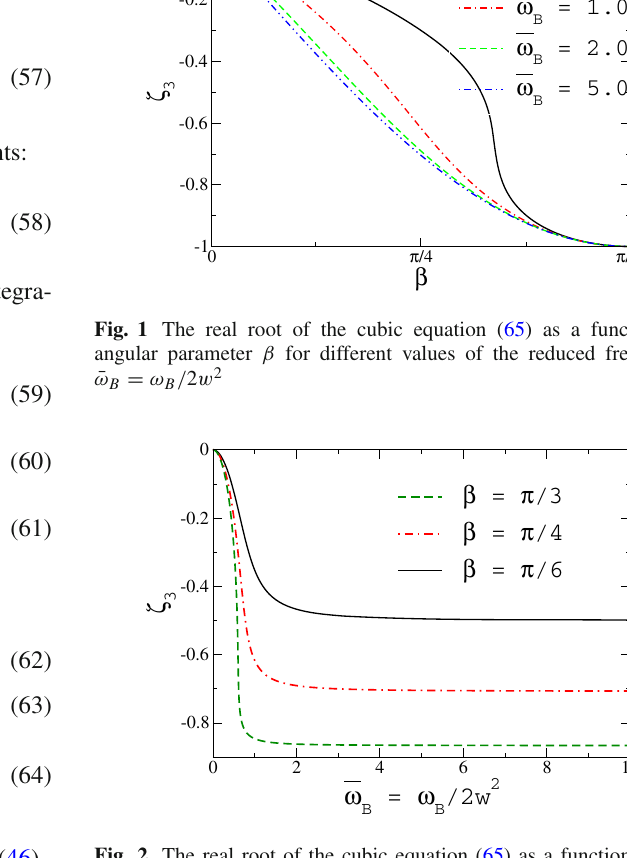
β . One can see that ζ − 1 3 monotonically decreases from 0 to with increasing β from 0 to π/ 2, and the indicated decrease is faster for larger ¯ ω B values. This means that the dissipation effect associated with the ζ 3 term in Eq. (58) is stronger for larger values of β and ¯ ω B . From Fig. 2 it can be seen that at a fixed value of β the real root ζ 3 drops from 0 to some asymp- totic value with increasing ¯ ω B . In agreement with Fig. 1, the modulus of the asymptotic value is larger for larger β . This observation is opposite to the behavior of the real part of two complex roots ζ 1 , 2 shown in Fig. 3. As follows from the results presented in Fig. 3, the dissipation effect associated with the ζ 1 , 2 terms in Eq. (58) appears to be weaker for larger values of β and ¯ ω B , in contrast to the ζ 3 case. The behavior of the imaginary parts of the complex roots ¯ ω ζ B is shown in Fig. 4. It can be seen that 1 , 2 as functions of the modulus of the imaginary parts grows with increasing β values merge ¯ ω B and the curves corresponding to distinct to nearly a linear function at large values of ¯ ω B . The propor- tionality coefficient asymptotically approaches unity.